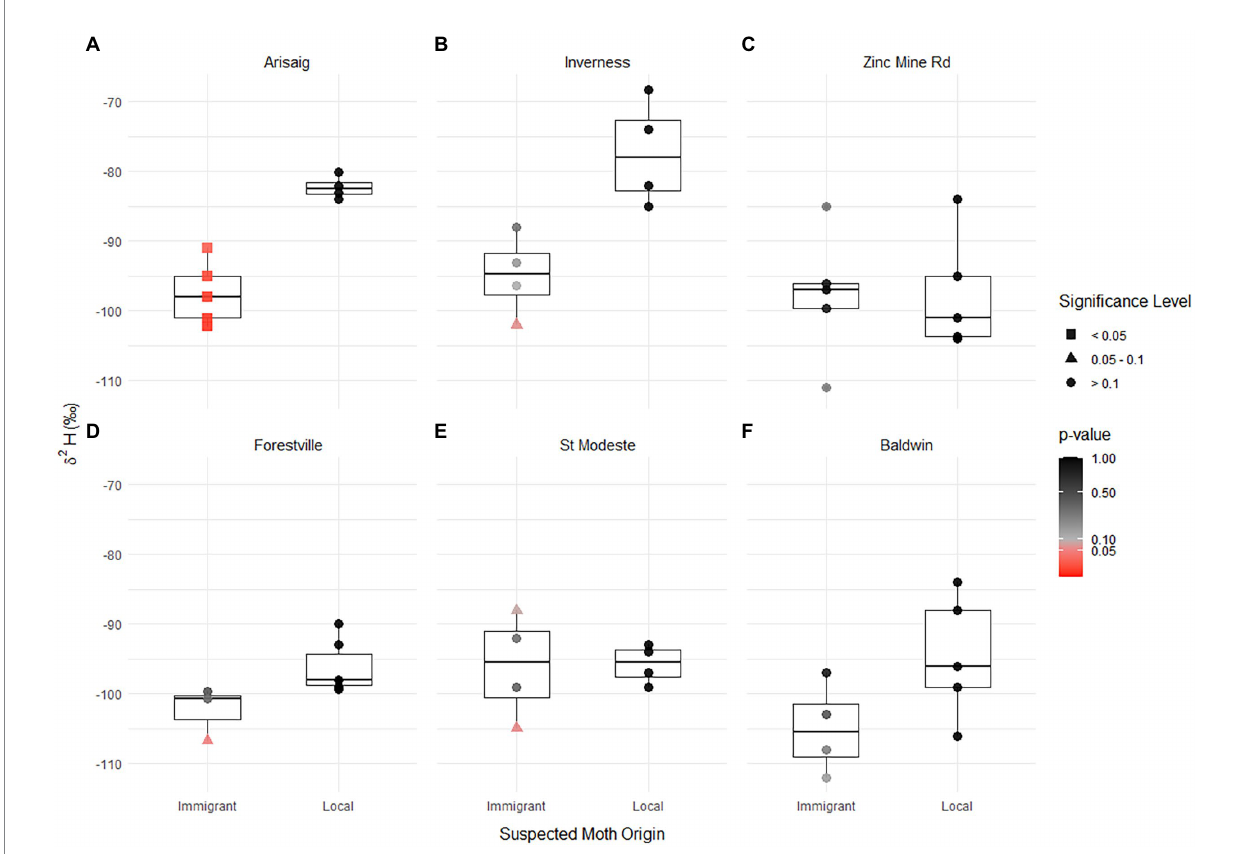
FIGURE 3 Box and whisker plot of δ 2 H values for immigrant and local spruce budworm individuals by sampling site (population, A–F ). Points represent individual samples. Putative local individuals are colored black, immigrant individual symbols represent whether they significantly differ from locals (squares; t -test; value of p <0.05), were not significantly circle (black; t -test; value of p >0.1) or were marginally non-significant (triangles; t -test; 0.1 > value of p